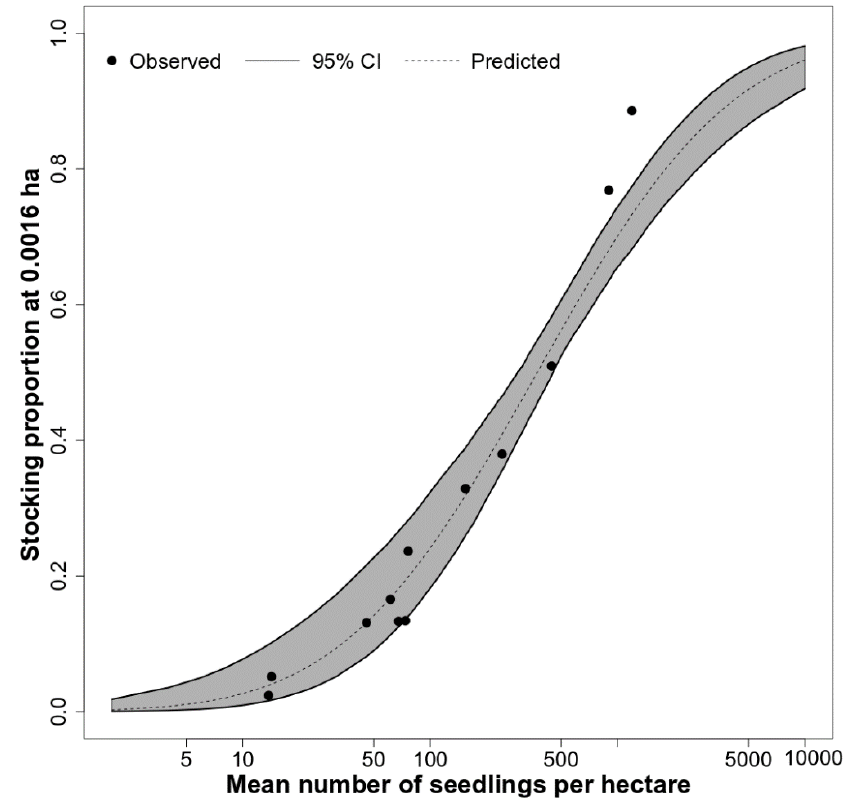
Figure 2. Observed stocking proportion of natural regeneration in 2018 (black points) with model fit of 0.0016ha stocking (dashed line) and bootstrapped 95% confidence interval (grey) from Ritchie (2020).